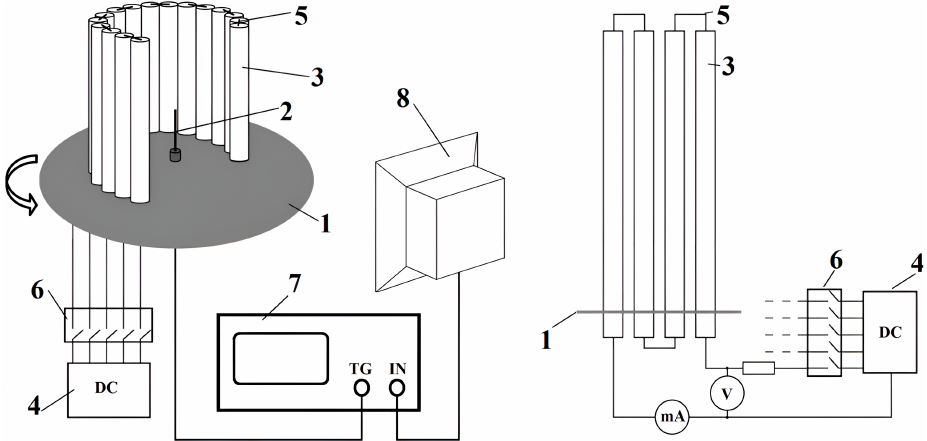
Figure 1. Plasma antenna system: 1—metal plate generator; 2—short linear antenna; 3—fluorescent lamps; 4—DC power supply; 5—connecting jumpers; 6—switchboard; 7—Rigol DSA815-TG spectrum analyzer; 8—Ocean Microwave OBH-1080 broadband horn antenna.